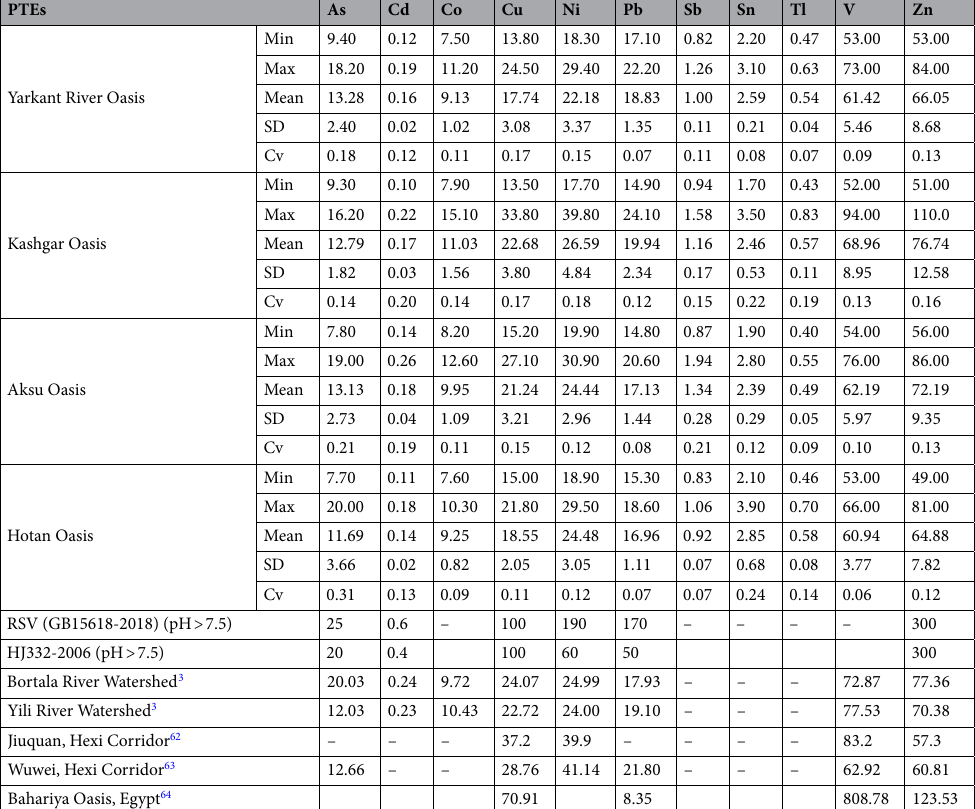
Table 1. Descriptive statistics of PTEs of oasis agricultural soil in the source region of the Tarim River.